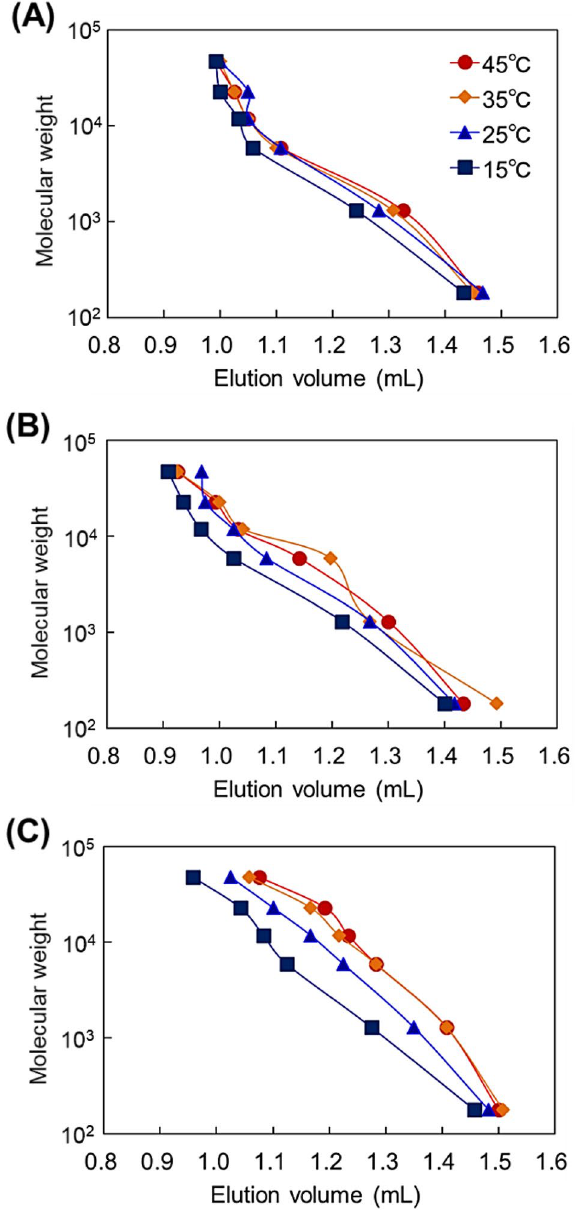
Figure 8. Plots of molecular weight of glucose and pullulan standards and their elution volume through P(NIPAAm- co -BMA) hydrogel-modified bead columns with ( A ) 7-nm pore-diameter beads, ( B ) 12-nm pore- diameter beads, and ( C ) 30-nm pore-diameter beads as base